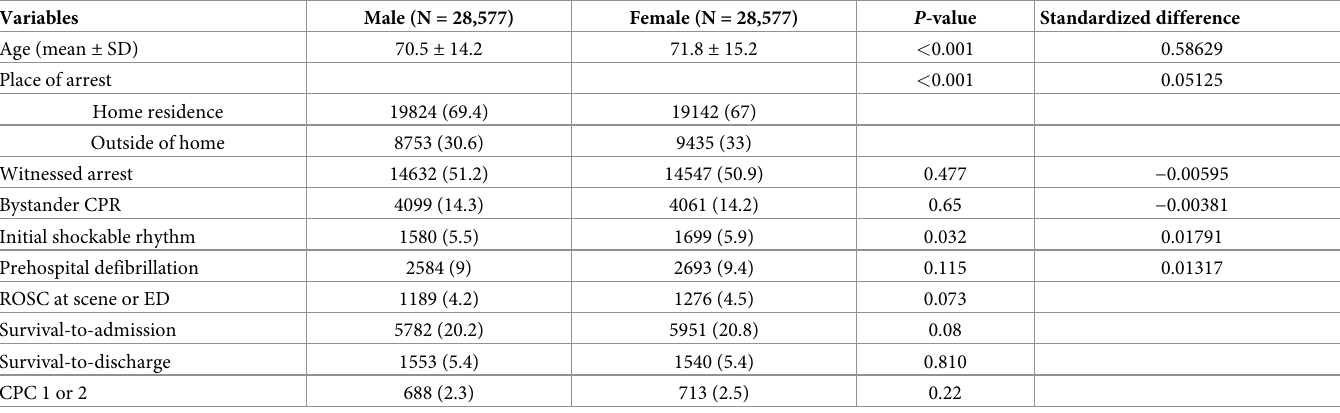
Table 3. Characteristics of patients with out-of-hospital arrest by sex after propensity score matching (total number = 57,514). Variables